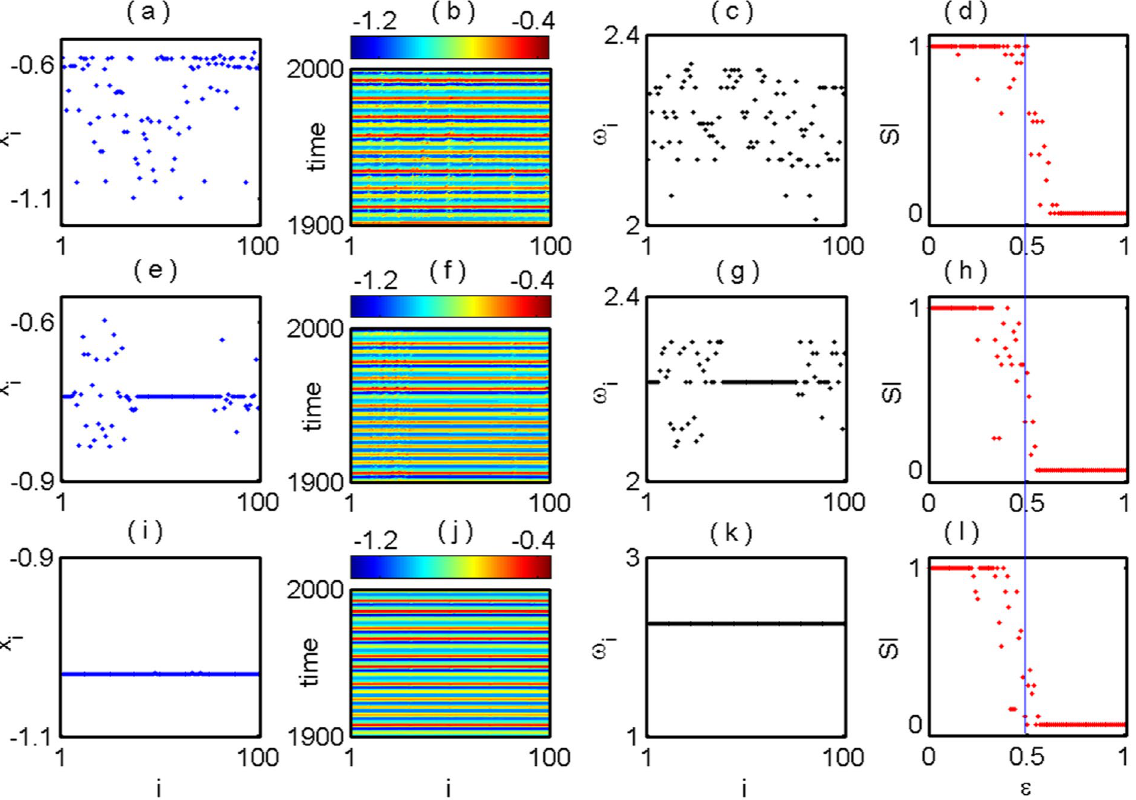
Figure 7. Globally coupled Mackey-Glass oscillators: The coexistence of different collective states at a fixed value of coupling strength = . 0 5  . First, second, third and fourth panels show the snapshots of x i (blue points), spatiotemporal plot, time average phase velocity (black points) and variation of SI (red points) by changing coupling strength  respectively. Again first, second and third rows are the results for different initial conditions j i j j i j j i j = − = − = − − + + a a a ( 1) , ( 1) , and ( 1) respectively for i = 1, 2, …, N and j = 1, 2, …, = n 25 . ij ij ij 2027 2001 247 A blue line is marked along the coupling strength = . 0 5  . Blue line intersect the SI value at ‘1’ in ( d ) which characterize the incoherent states corresponds to ( a ) and similarly it cuts the SI values in (0,1) in ( h ) and ‘0’ in ( l ) which resembling the chimera and coherent states correspond to the ( e ) and ( i ) respectively. Here N =